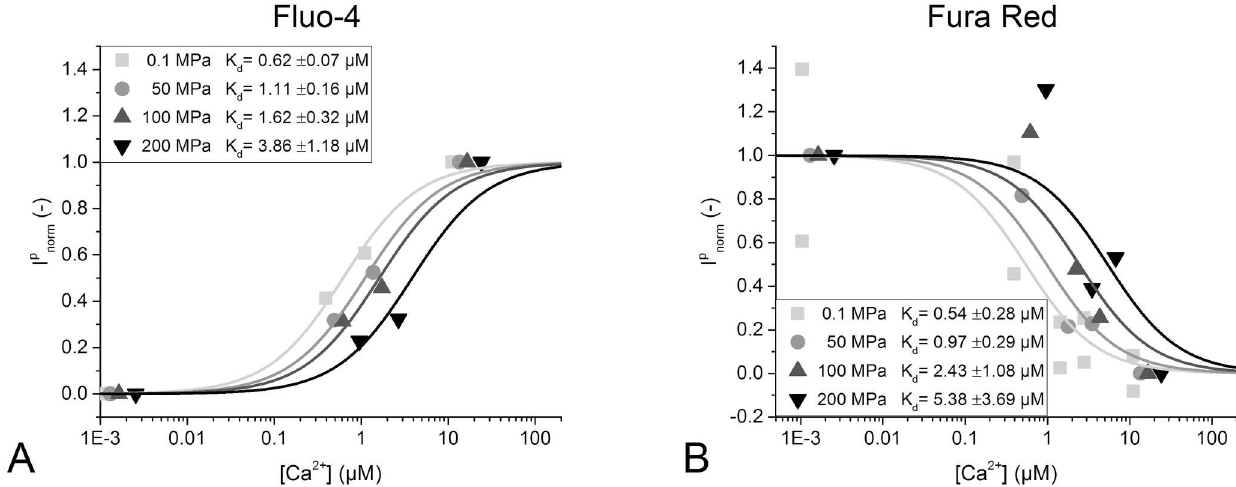
Fig 7. Free Ca 2+ calibration under high hydrostatic pressures. Graphs of normalizedfluorescence intensity I p (cid:138) are fitted with a Michaelis-Menten Eq (4) to determine the dissociationconstant of the calcium-dye binding K p concentration ½ Ca 2 þ free hydrostatic pressure p . The recordings from one sample batch each are shown for Fluo-4 (A) and Fura Red (B), respectively. The resulting K p are depicted in each graph and increase with hydrostatic